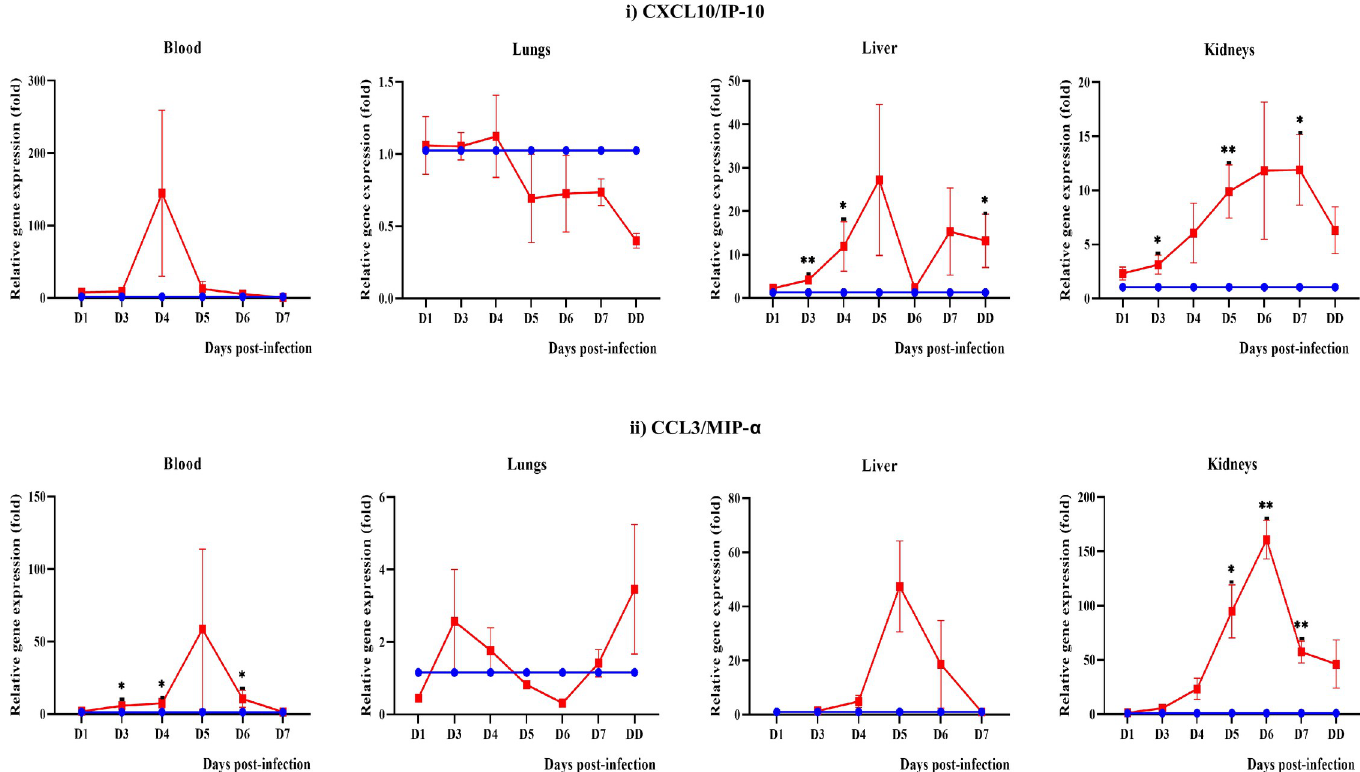
Fig 13. Modulation of chemokines in blood, lungs, liver and kidneys of control (blue line) and infected hamsters (red line). D1-D7: Day 1 to day 7. DD: dead � P � 0.05, �� P � 0.01, ��� P � 0.001. Control. The fold gene expression value can be found in S3 Table.